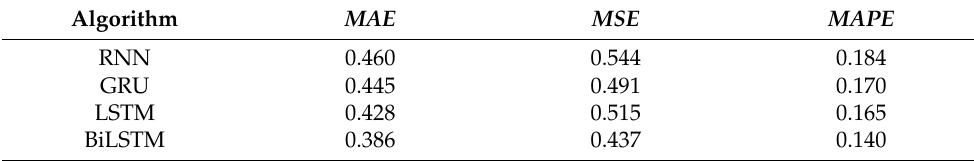
Table 6. Predictive performance comparison of the proposed model with other models.